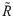
Panel (a) shows the value of the estimate of h1 for different values of s as a function of the number of classes, R˜, for twitter-like graphs with parameters p = q = 0.5, R = 32. Panel (b) gives a schematic representation of the estimated optimal number of classes R˜* as s varies.